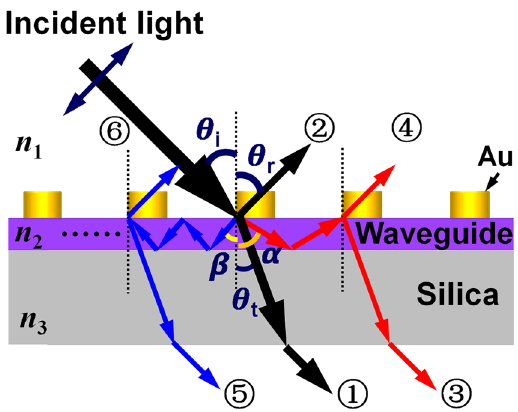
Figure 4: Diffraction process of light in